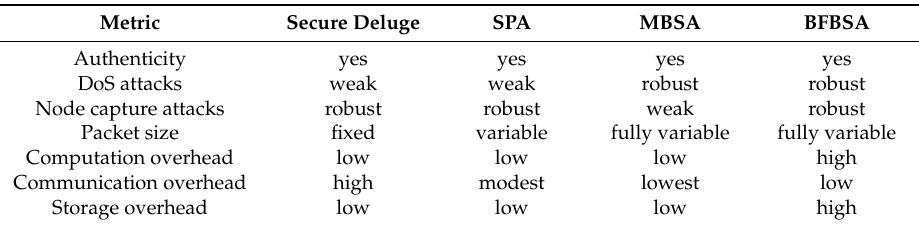
Table 3. Comparisons of Source Authentication